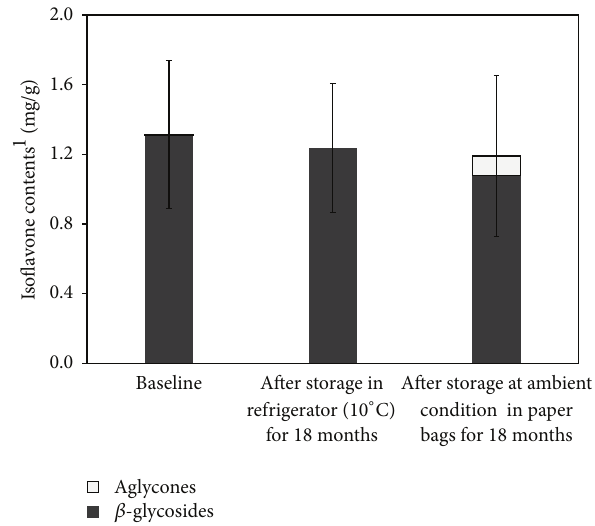
Figure 5: Isoflavone content in sound seeds of 14 soybean varieties planted at SUT Farm on 19 December 2009, at baseline and after storage under different conditions. Sound seeds of each soybean variety were extracted and assayed in triplicate. Bars and error bars represent mean ± standard deviation. 1 Isoflavone content was the summation of daidzin and genistin